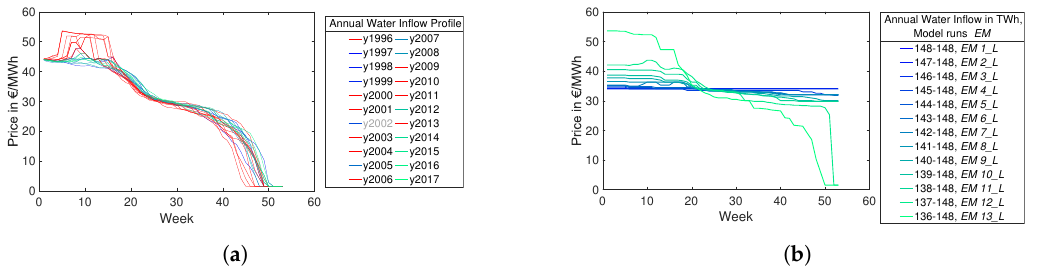
Figure 7. Impact of profiles and constant primary energy prices. ( a ) impact of water inflow profiles (example: model run EM 12_ L ); ( b ) impact of primary energy